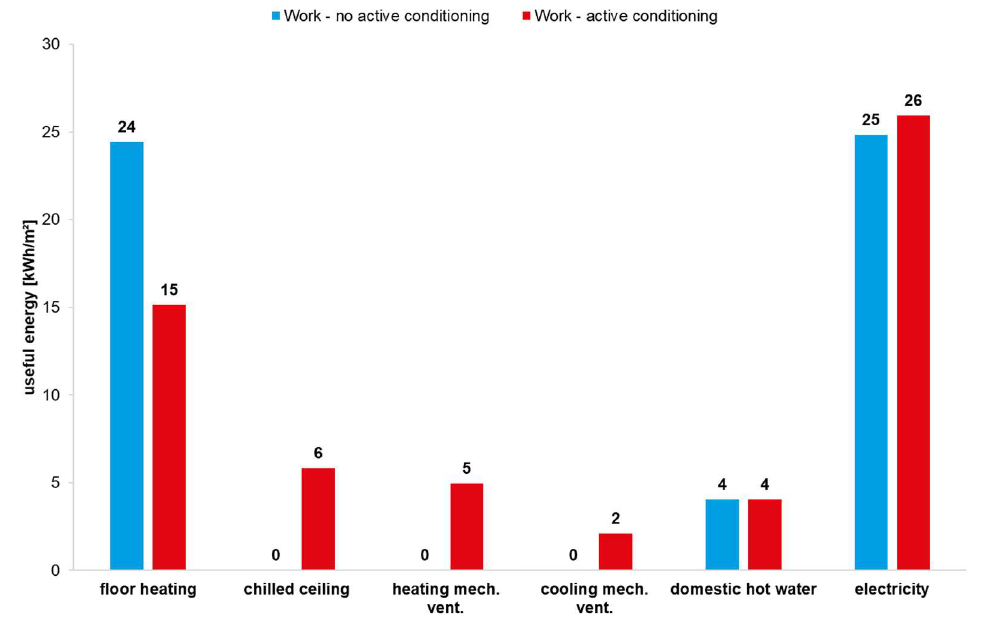
Figure 4. Energy demand per m 2 of different areas with (red) and without (blue) active conditioning (own